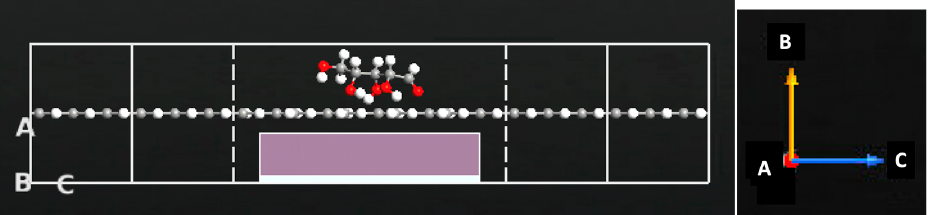
Figure 4. Cross-sectional view of the GNR-FET device with xylose.